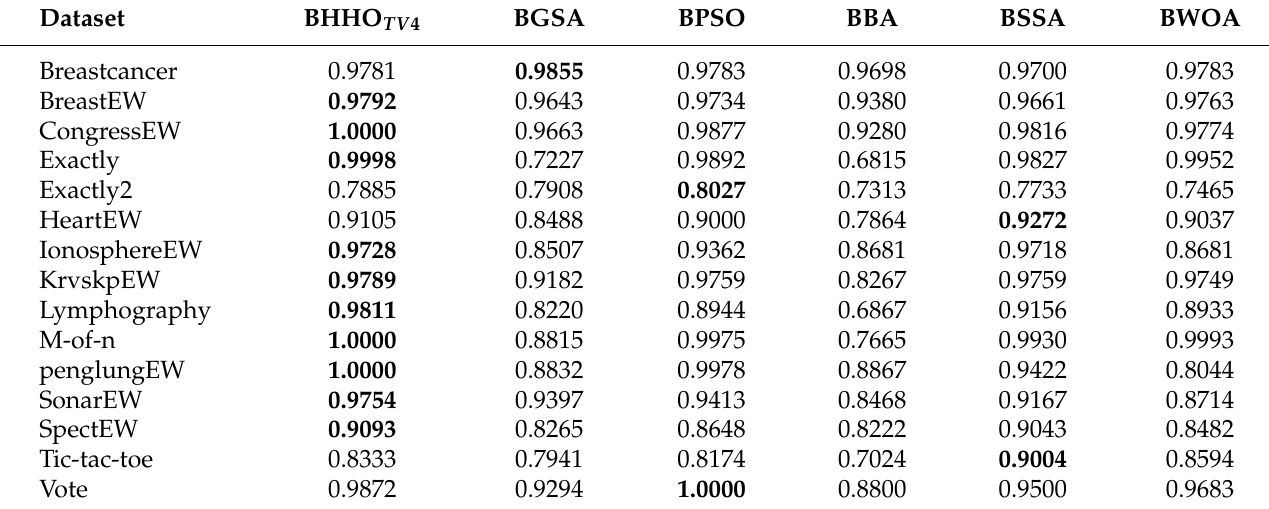
Table 7. Comparison of BHHO TV 4 versus other optimizers in terms of average classification